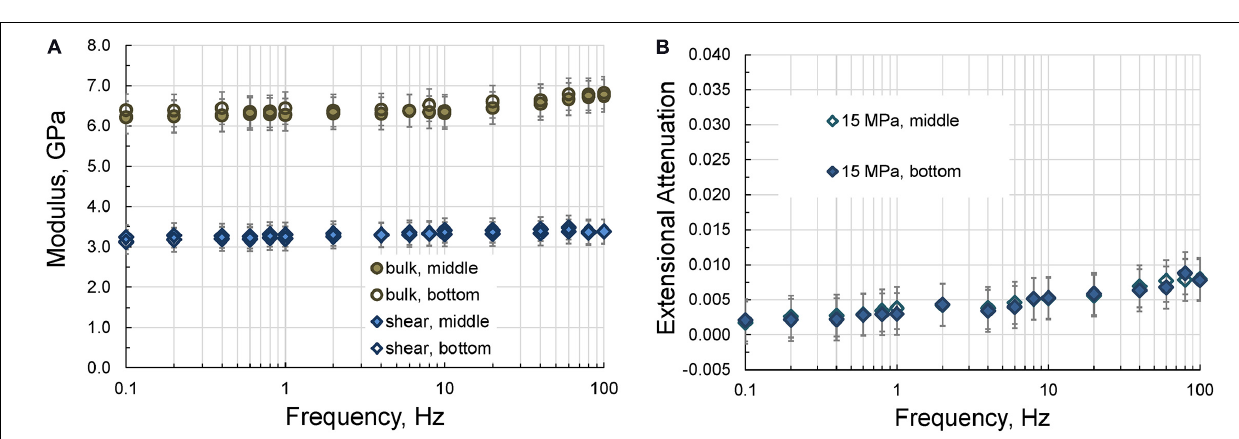
FIGURE 5 | The frequency dependences of the bulk and shear moduli (A) and the extensional attenuation (B) measured on the 15-cm acrylic sample in the middle and at a distance of 2 cm from the lower end of the sample at a uniaxial pressure of 15